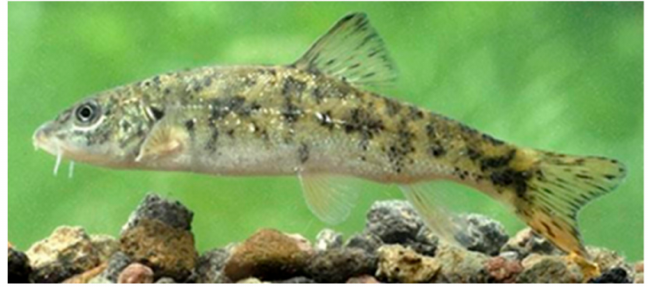
Figure 7. Swamp (hrv.: potoˇcna mrena) Barbus balcanicus. .